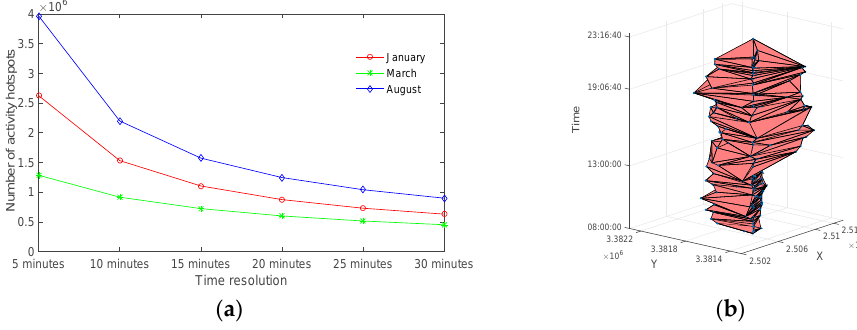
Figure 3. Human activity hotspots for the three months: ( a ) the number of activity hotspots decreases with the increasing value of time resolution from 5 min to 30 min; ( b ) 3D boundary of an activity hotspot lasting from 1 January 2013 08:07:26 to 1 January 2013 22:19:14, where its spatial area expands at approximately 13:00.